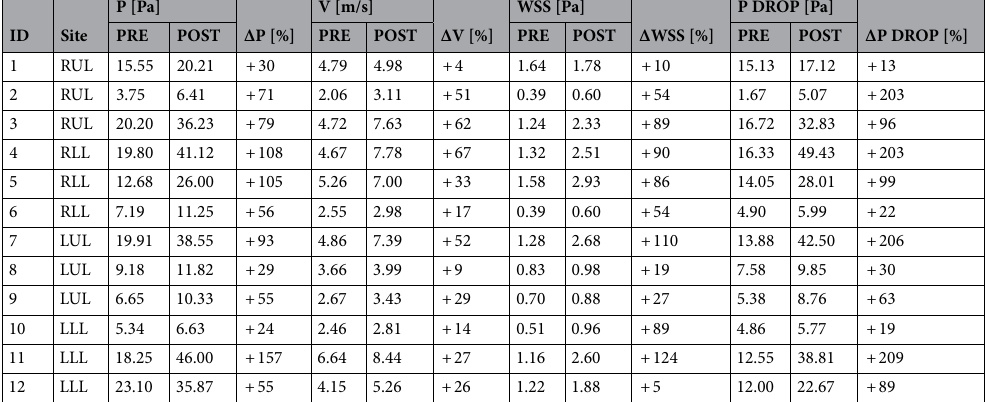
VFR lobar distribution. Figure 4 shows the distribution of VFR for the subjects under analysis grouped according to the site of lobectomy. In the pre-operative models (white bars), the right lung received a higher amount of flow. Lower lobes showed higher flow than the upper ones, and the RML was the lobe constantly receiving less flow. The post-operative models revealed considerable rearrangements of the VFR distribution for all the typologies of lobectomy considered. In the comparison of the overall population, significant differences arose between the pre and post-operative models for both the operated lung (p < 0.001) and the contralateral lung (p < 0.001). However, if the lobe to be removed is neglected in calculating the VFR to the operated lungs, the difference between the pre and post-operative configurations is not significant (p = 0.121). Finally, in the post-